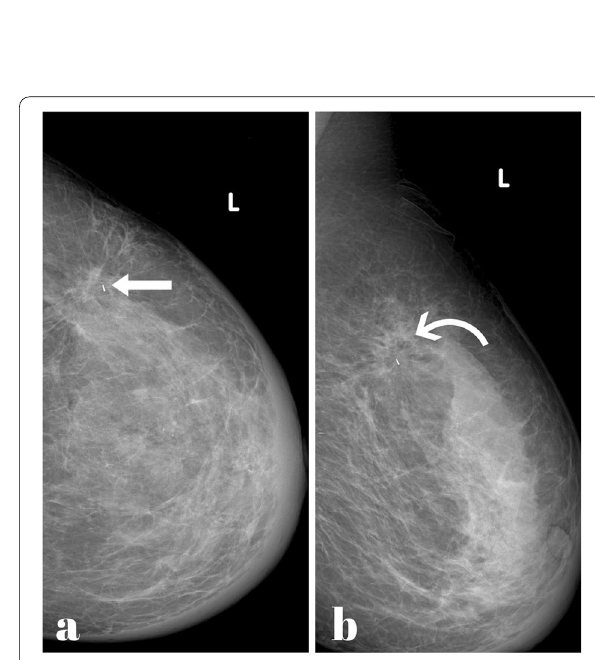
Fig. 5 Fifty‑seven years old lady diagnosed as NOS IDC. a – b shows left CC and MLO mammograms with an upper outer quadrant isodense speculated mass [curved arrow] associated with architecture distortion and diffusely thickened breast skin. The clip is inserted within the mass [straight